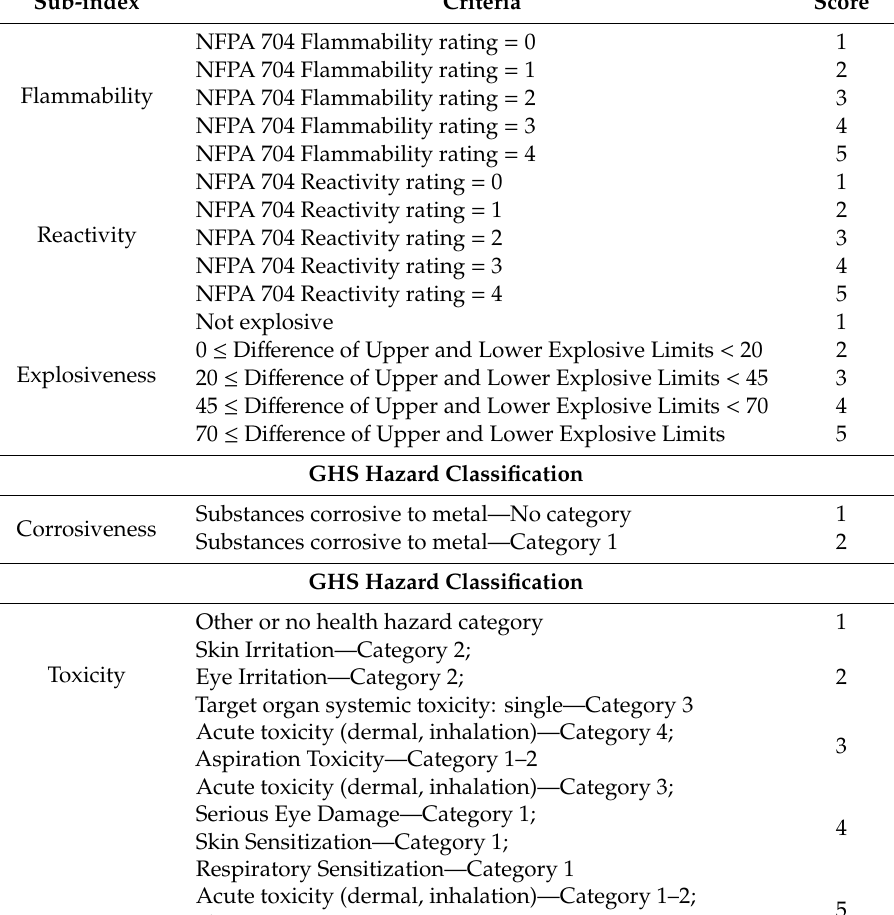
Table A1. Criteria and score of the individual chemical factor sub-indices.